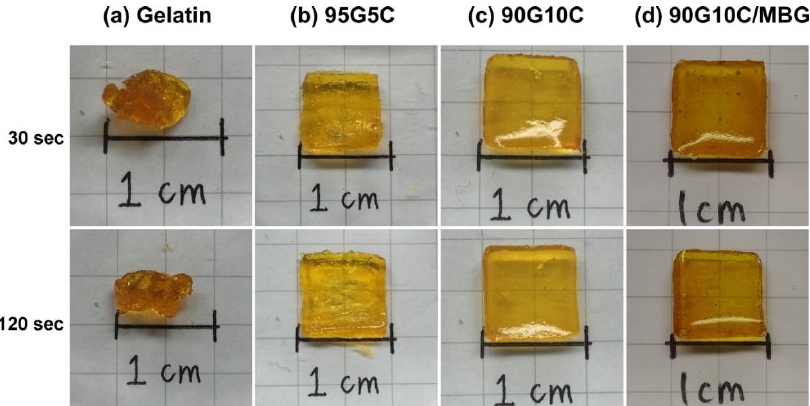
Figure 2. Images of various sealant compositions exposed to LED light for different durations, with ( a ) gelatin, ( b ) 95G5C, ( c ) 90G10C, and ( d ) 90G10C containing 20% mesoporous bioactive glass (MBG).